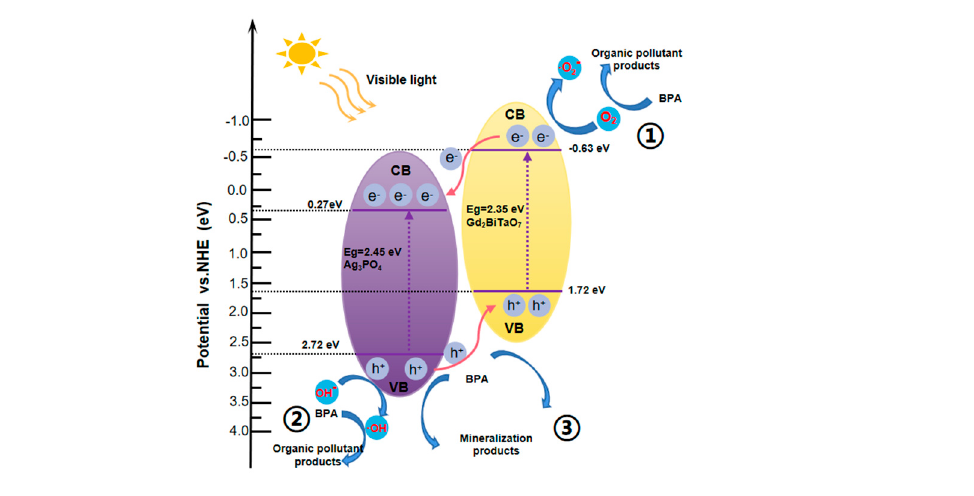
Figure 20. Possible photocatalytic degradation mechanism of bisphenol A with Ag 3 PO 4 /Gd 2 BiTaO 7 heterojunction as photocatalyst under visible light irradiation.